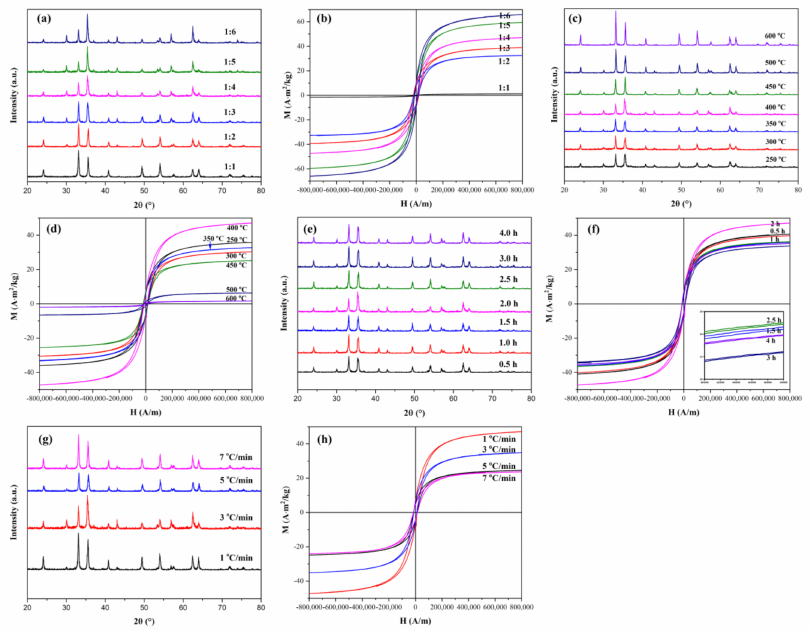
Figure 3. XRD patterns and hysteresis loops of Fe 2 O 3 /Fe 3 O 4 heterogeneous nanoparticles with various molar ratios of ferric nitrate and urea ( a , b ) calcined at various temperatures ( c , d ) for different times ( e , f ) with different heating rates ( g , h